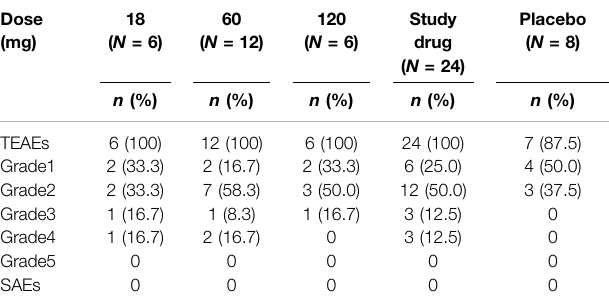
TABLE 2 | Summary of adverse events (excluding pregnancy event).